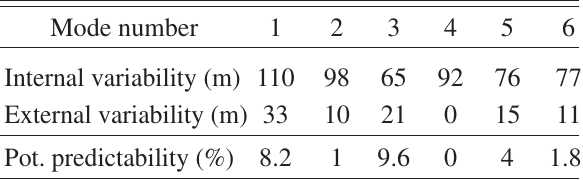
Table III. Results from ANOVA technique (internal variance, external variance and potential predictability) for different dominant atmospheric modes and for the experiment ATL. The 99% significance level is reached when potential predictability is 6.34%.